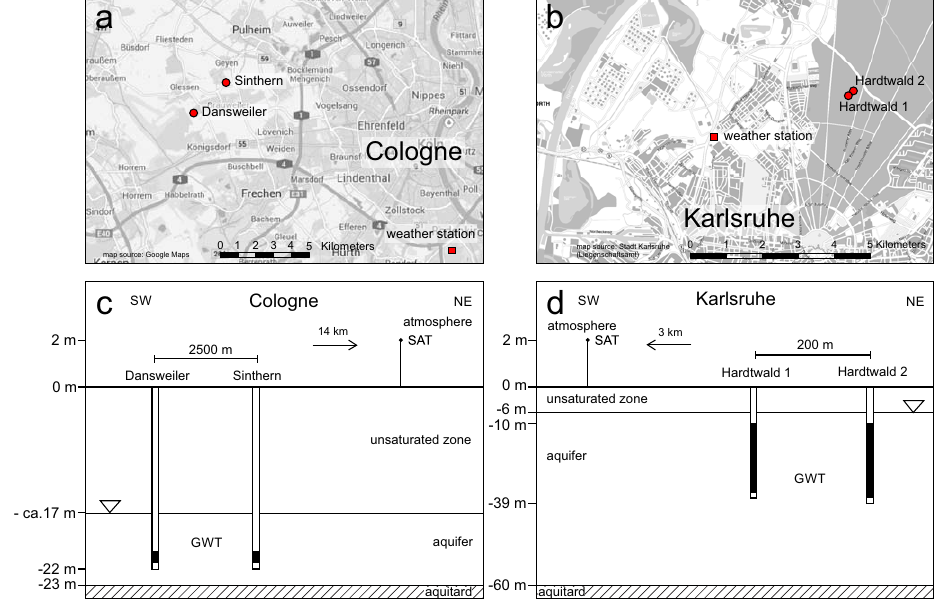
Figure 1. (a, b) : locations of the four observation wells and two weather stations used in the present study. (c, d) : conceptual sketch of the well settings in the aquifers close to Cologne (left) and Karlsruhe (right). The black zones in the wells indicate the location of the filter screens. Please note the different scales in the